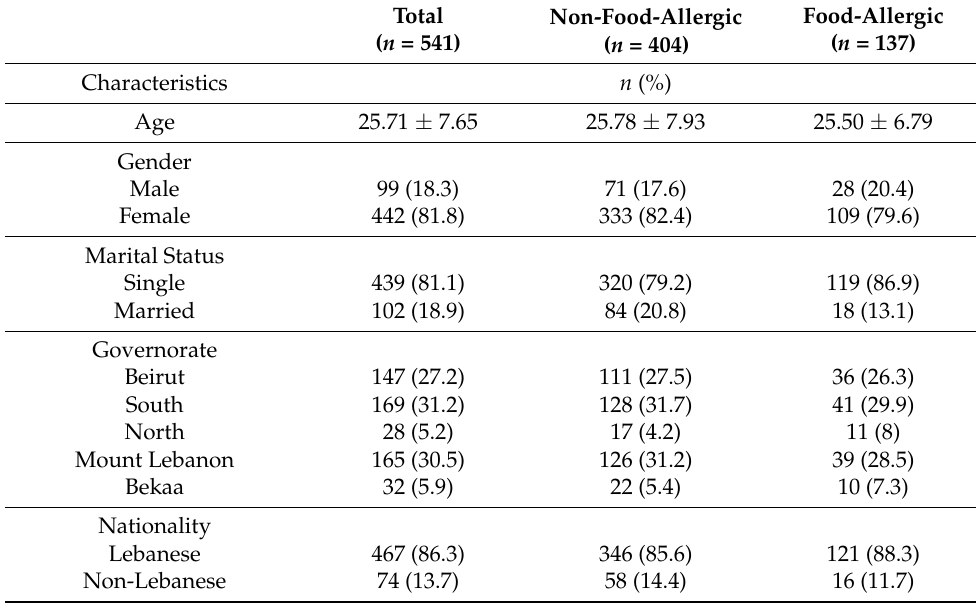
Table 3. Sociodemographic characteristics of the study population ( n = 541).